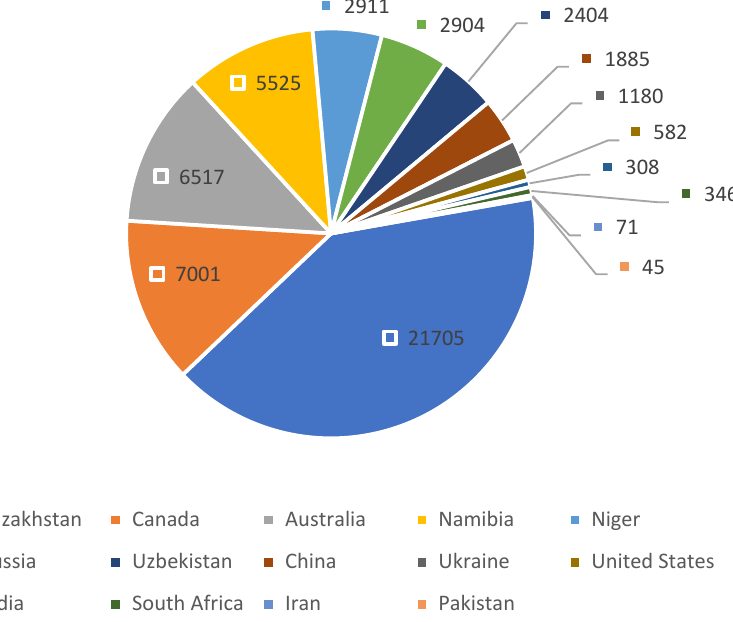
Figure 5. Uranium reserves in the world, Mg, own elaboration.